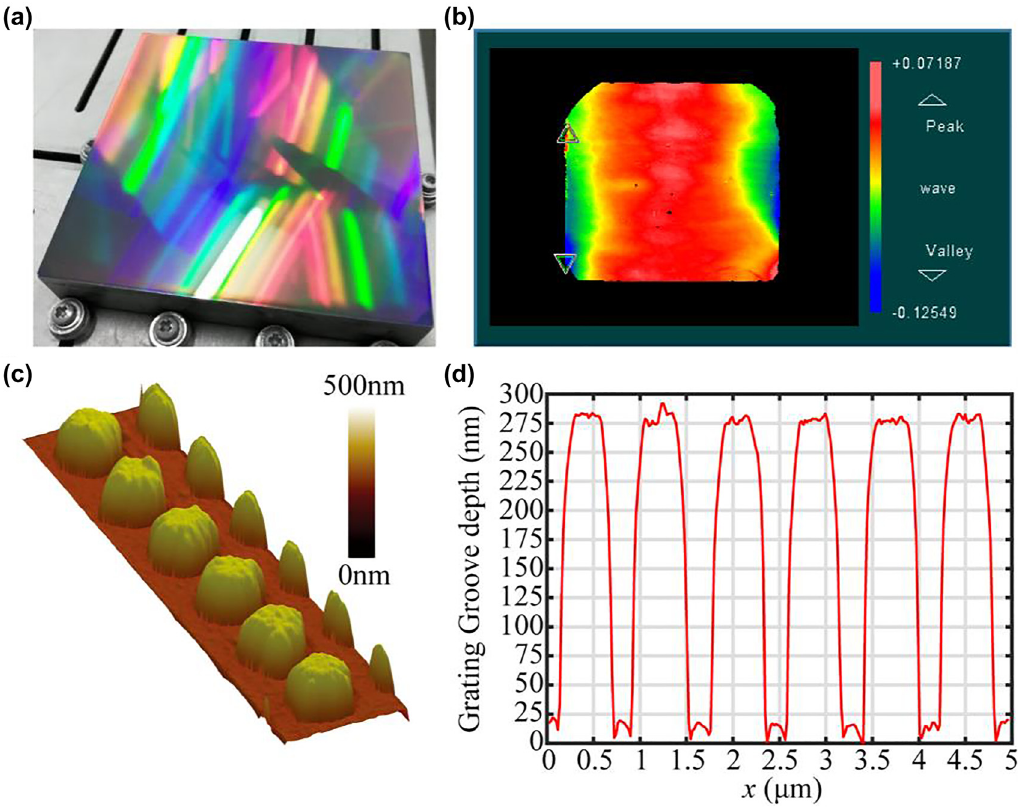
Figure 6: The frabricated two-dimensional grating. (a) Photograph of the two-dimensional grating made via scanned reactive-ion-beam etching (b) Diffraction wave front measured with a Zygo interferometer. (c) Atomic force microscope image and (d) cross-sectional view of the two-dimensional grating.